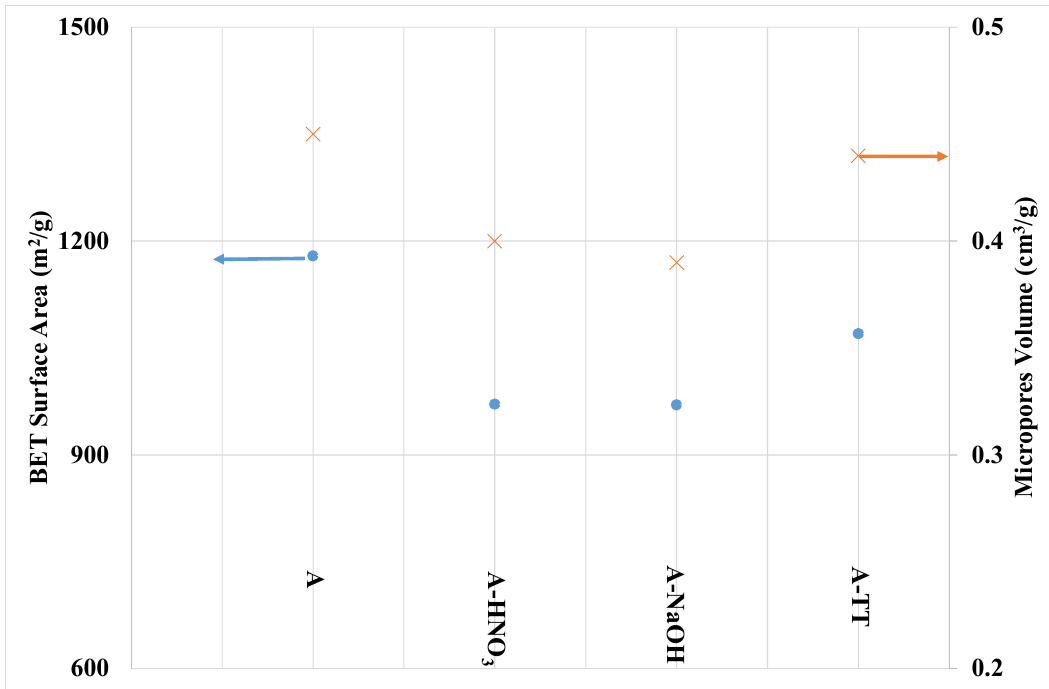
Figure 5. Brunauer–Emmett–Teller (BET) surface area and micropores volume (calculated by Horvath-Kawazoe method) for the different samples, deduced from N 2 adsorption isotherms carried-out at −196 °C.